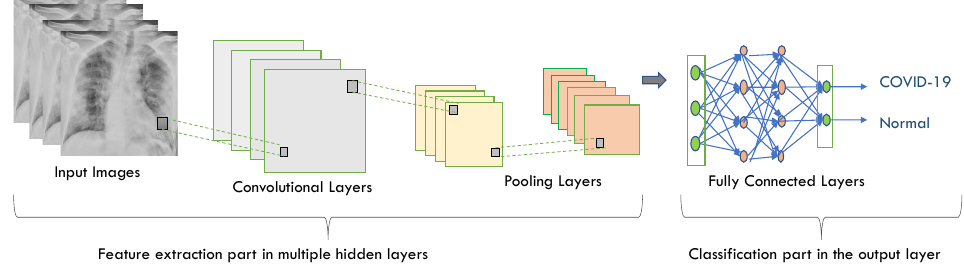
Figure 2. CNN architecture using chest X-ray images as an